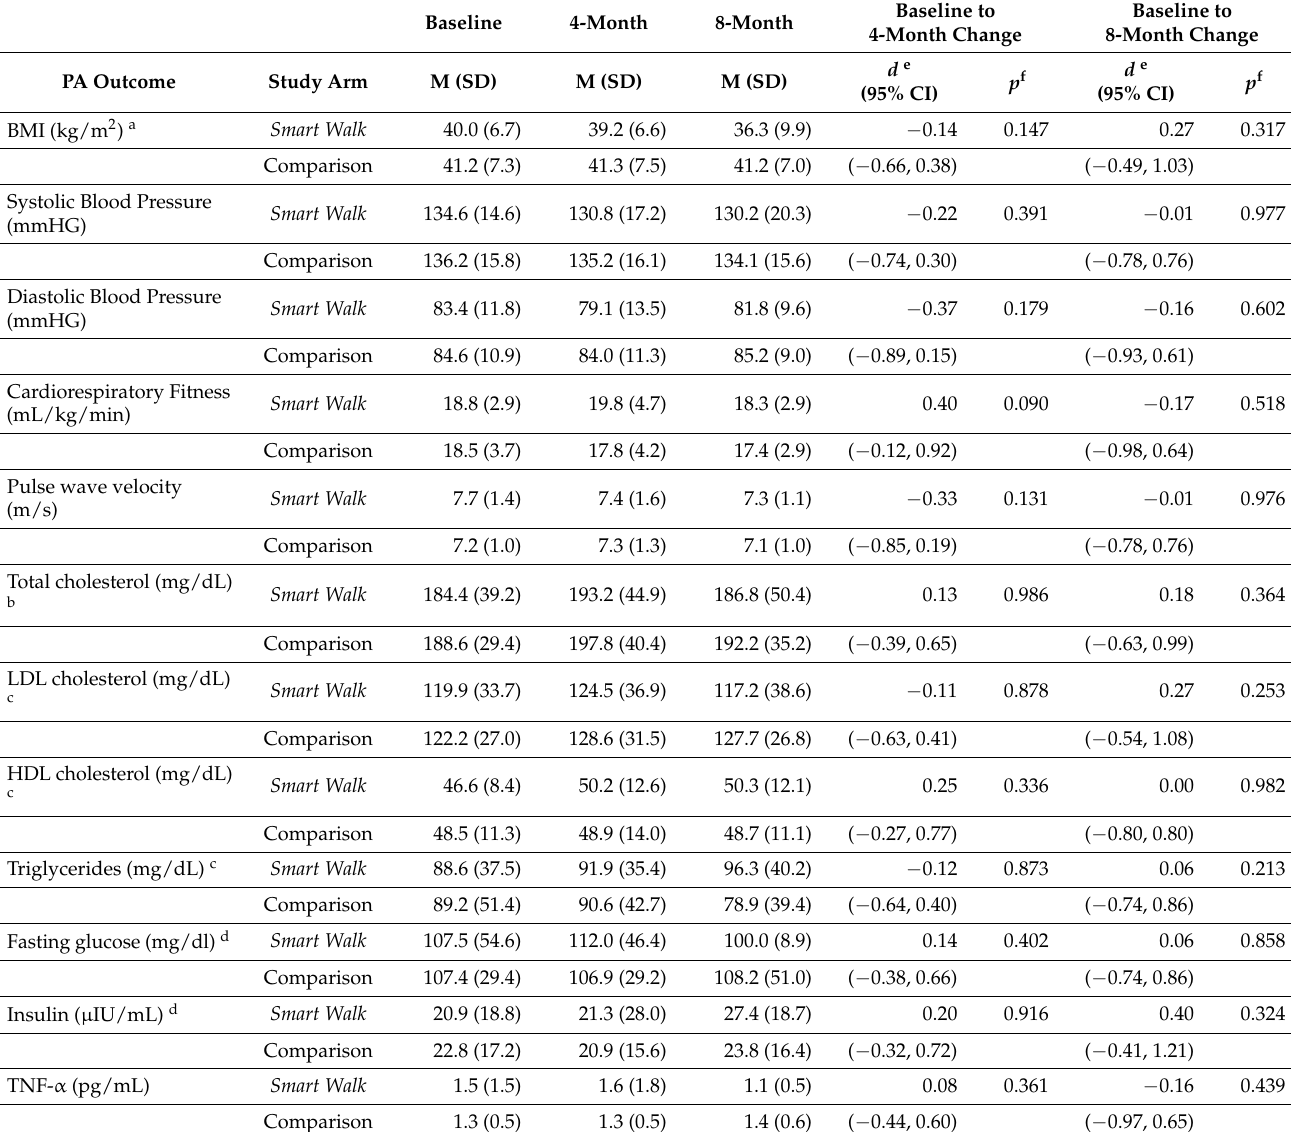
Table 8. Cardiometabolic Disease Risk